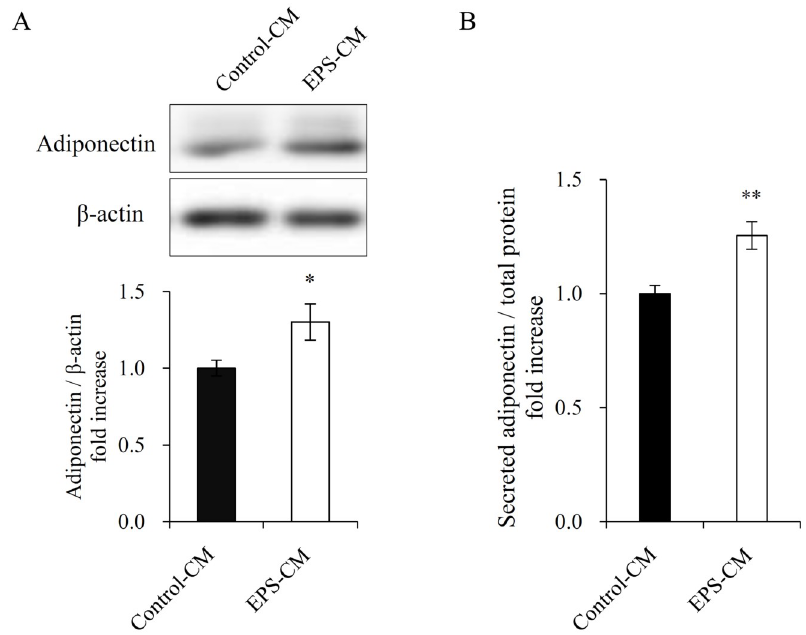
Fig 4. Effects of myotube EPS-CM treatment on adiponectin secretion of 3T3-L1 adipocytes. (A) 3T3-L1 adipocytes were continuously treated with 50% myotube EPS-CM, and on day 10 post-differentiation, cell lysates were subjected to immunoblotting for adiponectin. (B) Following the final 48 h treatment with myotube EPS-CM (day 8–10), the levels of adiponectin in the culture media of 3T3-L1 adipocytes were determined using ELISA. Data are expressed as mean ± SEM (n = 12 (A), n = 8 (B)). � ; p < 0.05. �� ; p <